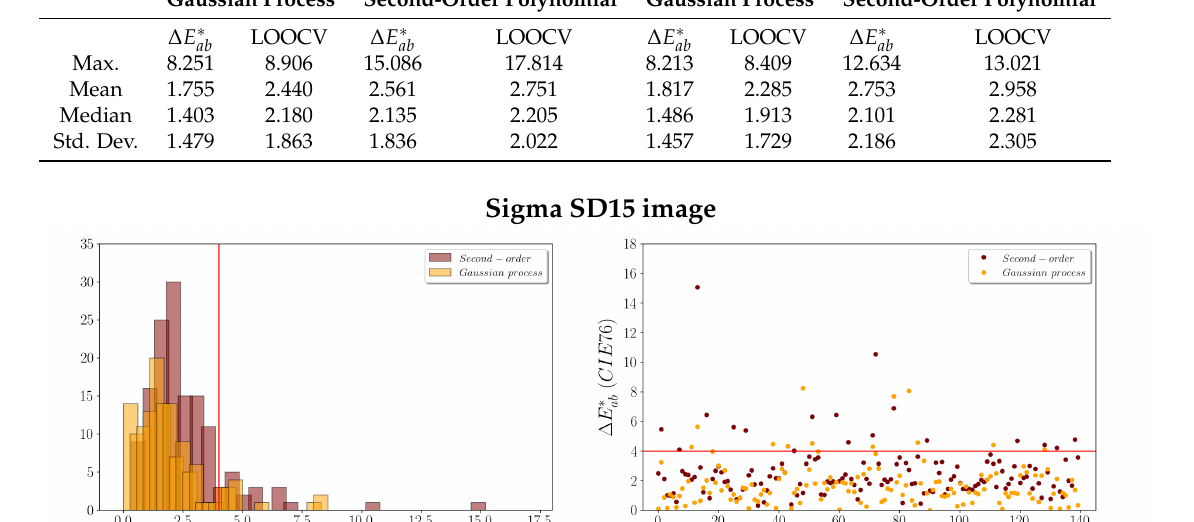
values for the X-Rite patches: ( a ) ∆ E ∗ ab